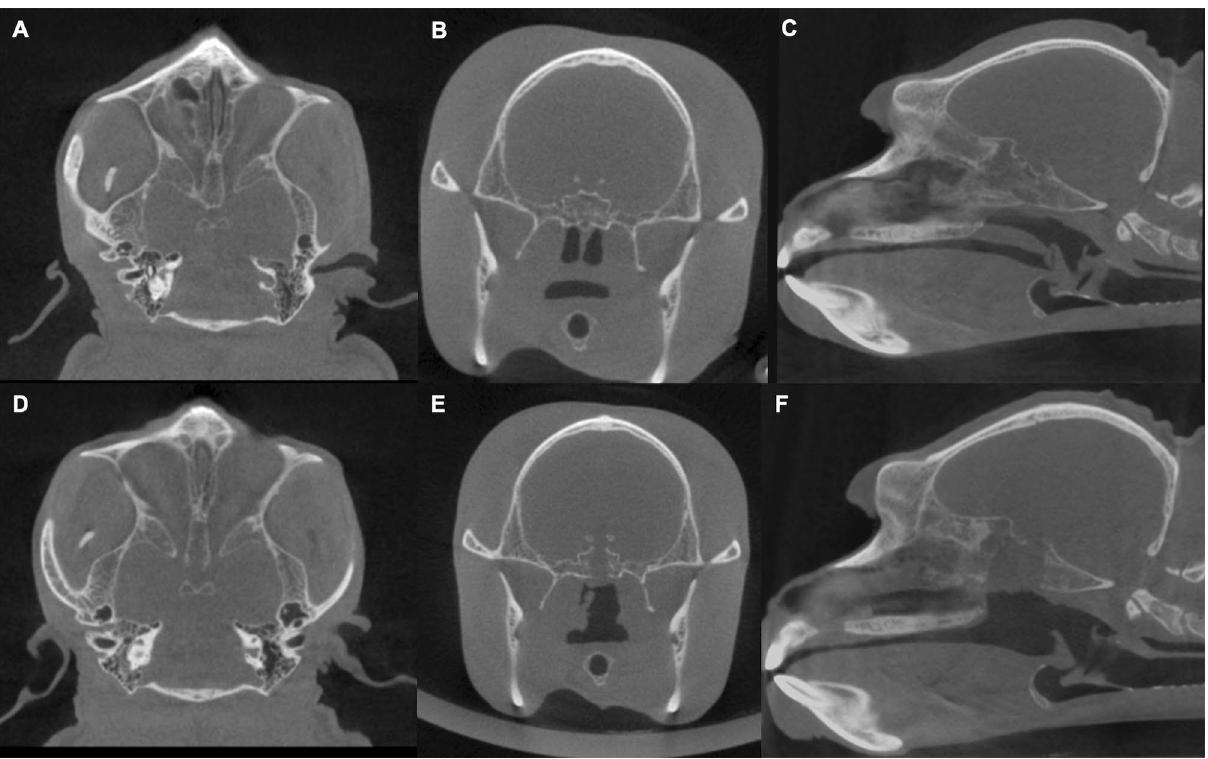
Figure 1. Preoperative and postoperative computed tomography scans. Preoperative axial ( A ), coronal ( B ), and sagittal images ( C ) show the sphenoidal sinus and pituitary fossa in the cynomolgus monkey. Postoperative axial ( D ), coronal ( E ), and sagittal images ( F ) show the bone removal in the sphenoidal